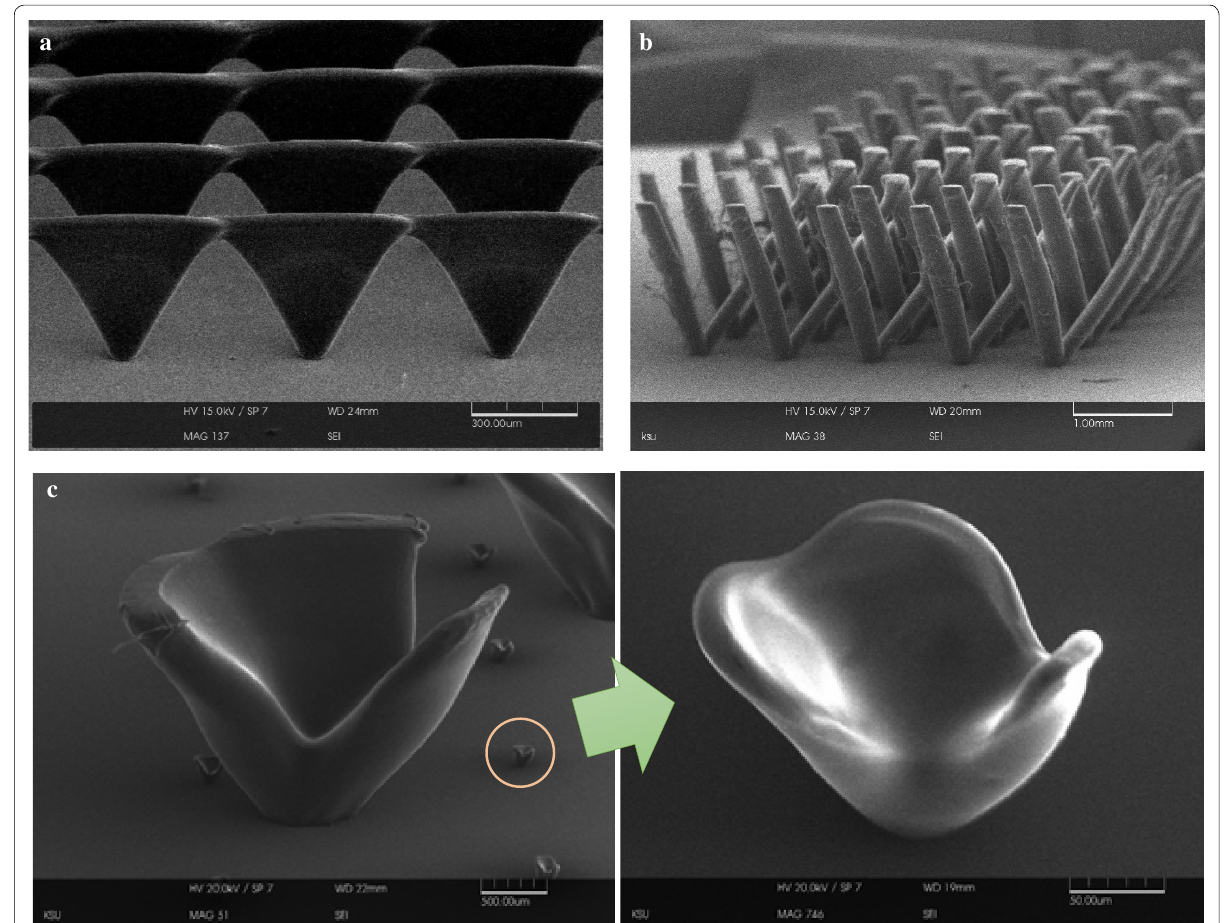
Fig. 11 Unique 3D SU-8 structures: a an array of ‘chained triangular slab’, b millimeter-tall SU-8 tripod array, c large (1.5 mm tall) and small (200 µm tall) 3D petal SU-8 structure on a single